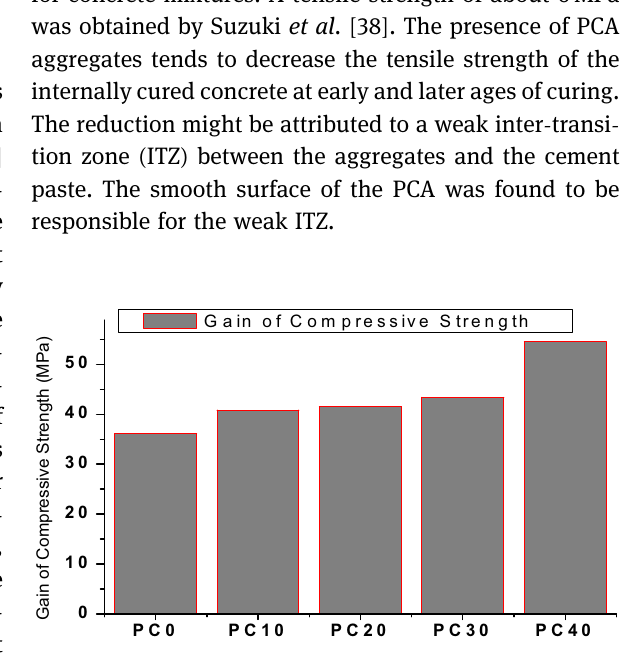
Figure 3: 28 - day gain of compressive strength of PCA mixtures correlated with the control mixture [ 38 ]